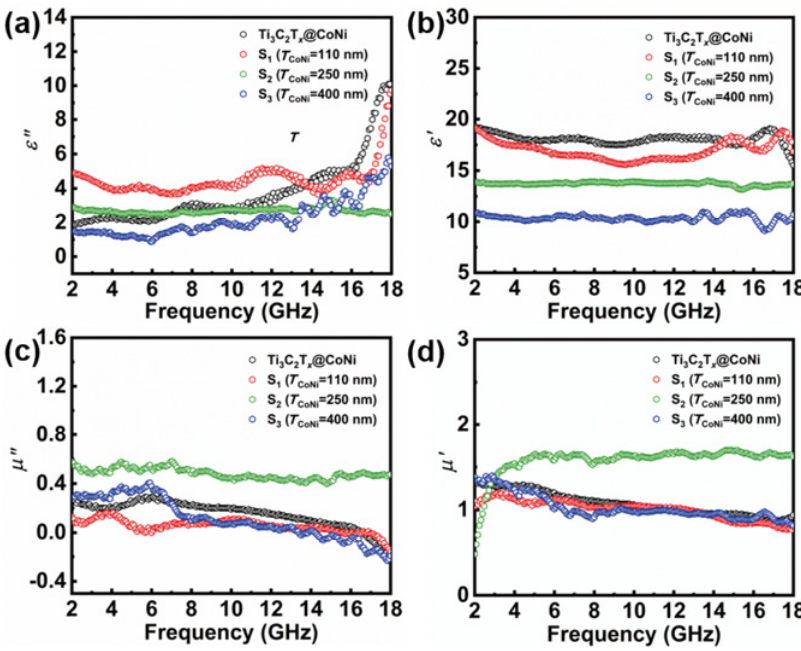
Fig. 4 Connection between electromagnetic parameters ((a) ε ″ , (b) ε ′ , (c) μ ″ , and (d) μ ′ ) and frequency ( f ) of 2D Ti 3 C 2 T x @CoNi nanosheets and SiO 2 @Ti 3 C 2 T x @CoNi microspheres ( T CoNi = 110, 250, and 400